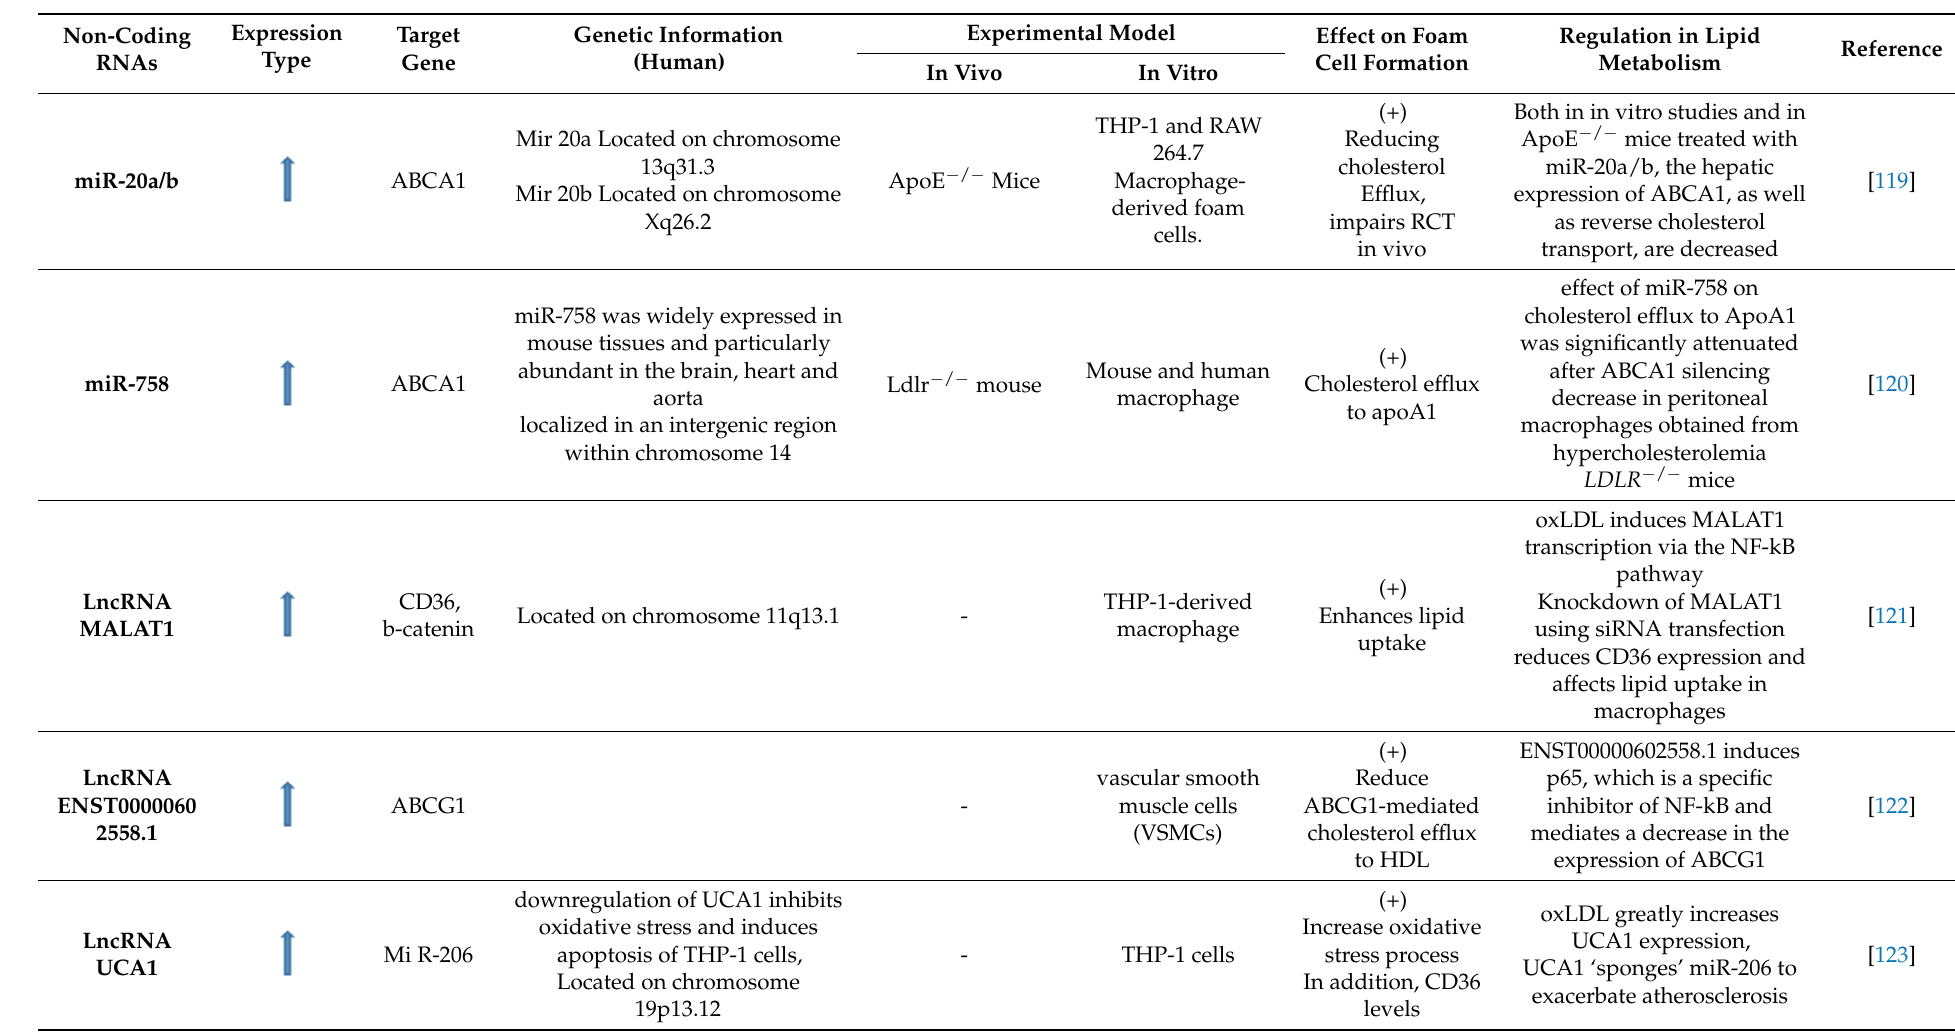
Table 1. Non-coding RNAs that stimulate foam cell formation/function. Table 1. Cont .